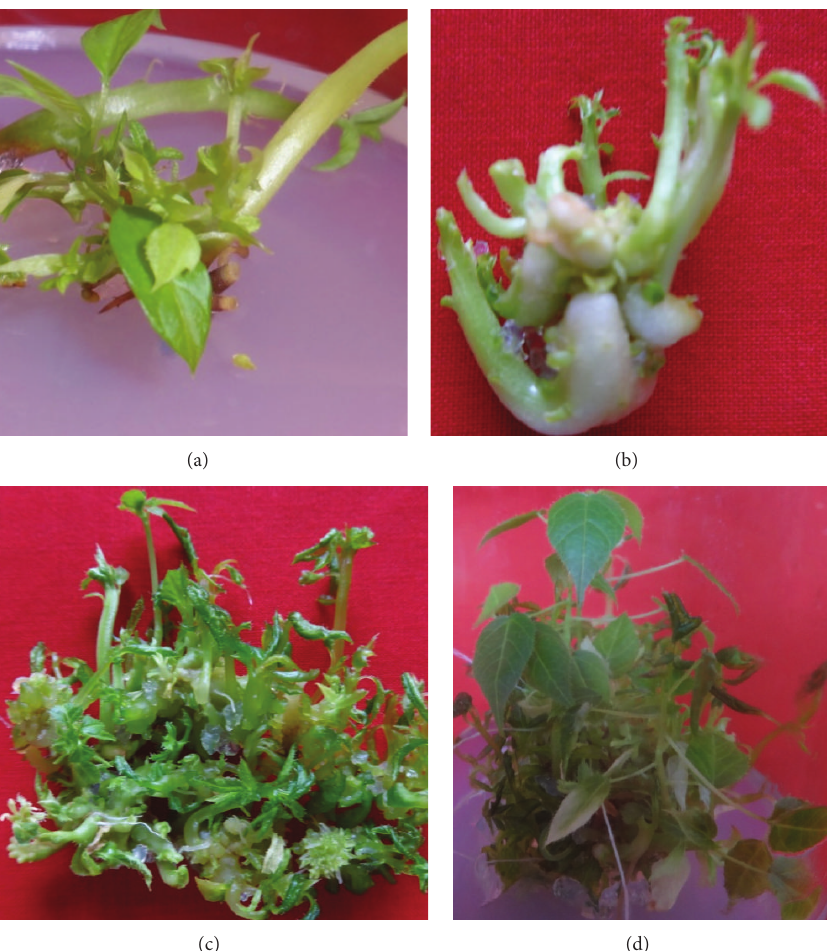
Figure 1: (a) Initiation of shoots from the nodal meristem. (b) Multiple shoots from the explants on MS medium with BAP. (c) Multiplication of shoots after two weeks. (d) Multiplication of shoots after four to five weeks.